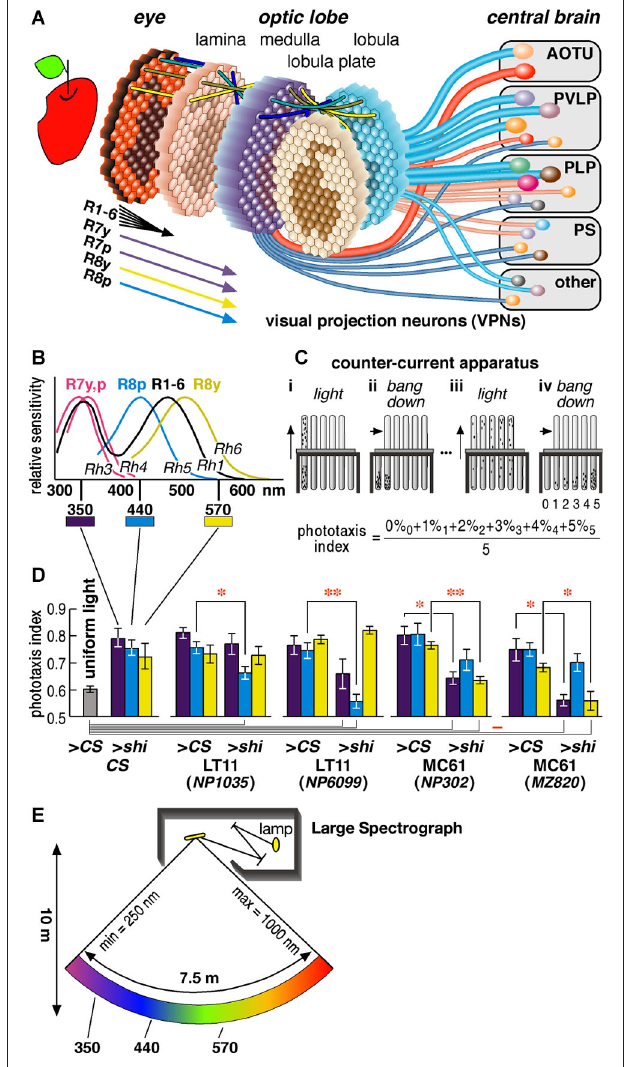
FIGURE 1 | Drosophila visual system and phototaxis assay. (A) Schematic diagram of the Drosophila visual system. Photoreceptors project from about 750 ommatidia of the retina to as many retinotopic columns (visual cartridges) in the four nested neuropils of the optic lobe. Relay interneurons project each retinotopic level onto the next (indicated by four colored lines on top of each neuropil). Hexagons with the projected images of an apple schematize the distribution of retinotopic visual cartridges and the relayed visual field. Cylindrical lines represent the visual projection neurons (VPNs) that connect the lower visual centers in the optic lobe to higher visual centers in the central brain (Otsuna and Ito, 2006). They terminate in the anterior optic tubercle (AOTU), posterior ventrolateral protocerebrum (PVLP), posterior lateral protocerebrum (PLP), posterior slope (PS) and a few other neuropils. The diameters of the lines reflect the numbers of neurons per pathway. Two red lines represent the pathways we analyzed in this study. (B) Sensitivity spectra of the photoreceptors (Salcedo et al., 1999). (C) The counter-current apparatus. Flies were put in the first tube and allowed to run towards the light for 30 s (panel i). The flies moved to the opposite tube were transferred to the bottom of the next tubes by tapping (ii) and let run towards light again (iii). After repeating this process five times (iv), flies were distributed to six tubes according to the times they moved towards light (0–5). (D) Phototaxis indices of the ( Continued